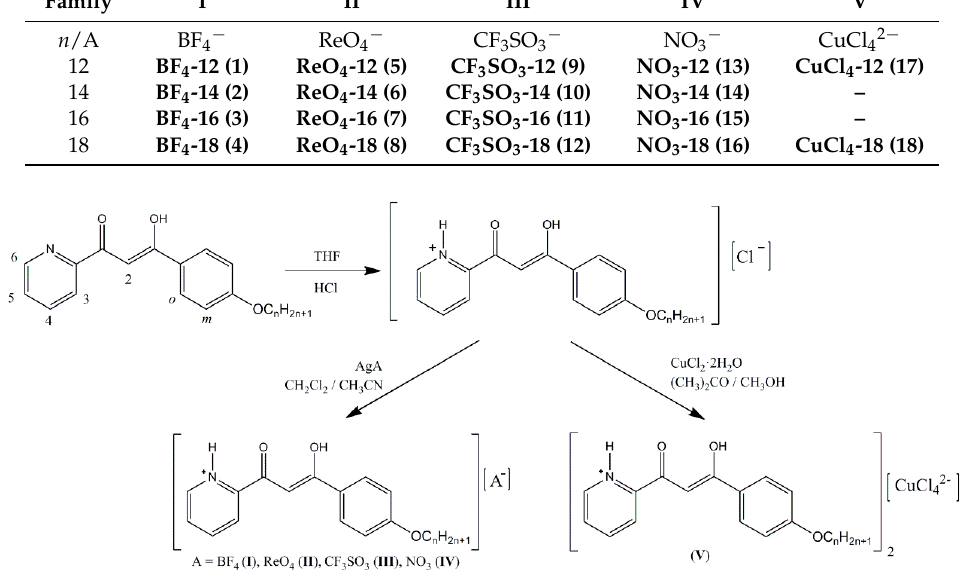
Table 1. Nomenclature proposed for the salts described in this work, including the numbering. Family I